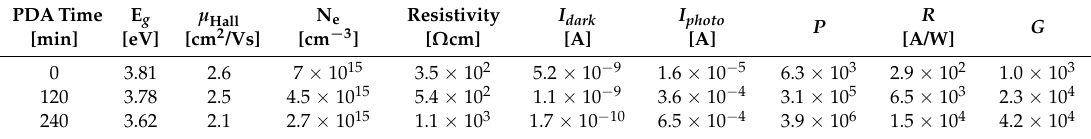
Table 1. Electric and UV photodetection characteristics of a-IGMO photo-TFTs with different PDA time. PDATime